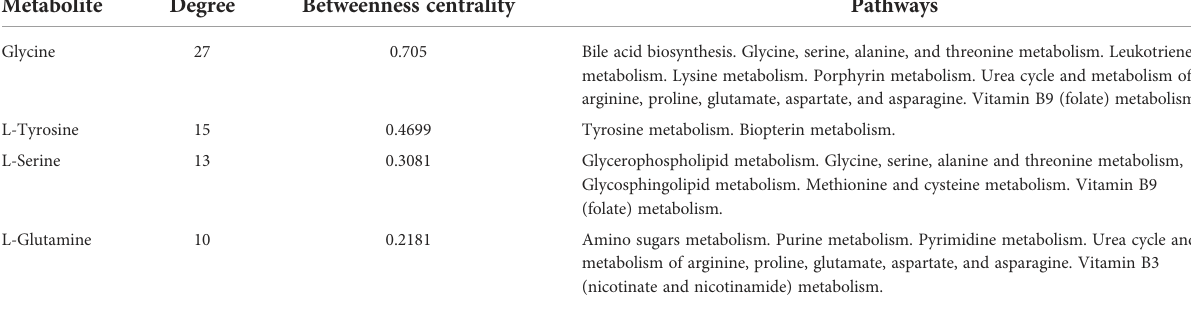
TABLE 5 Topological parameters of key metabolites classifying IPFD as an SVM-RFE model. Metabolite